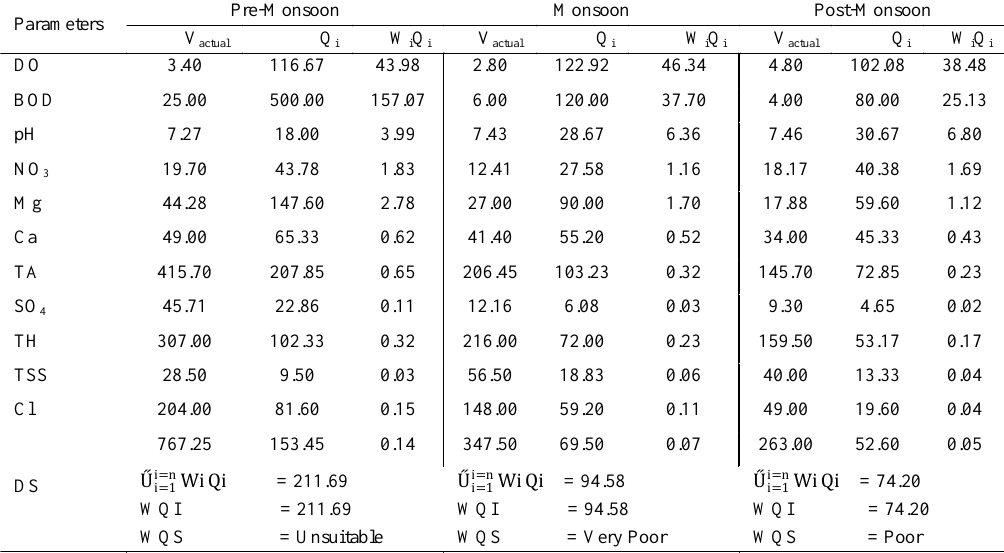
Table 7: Sample Calculation of WQI at S-1